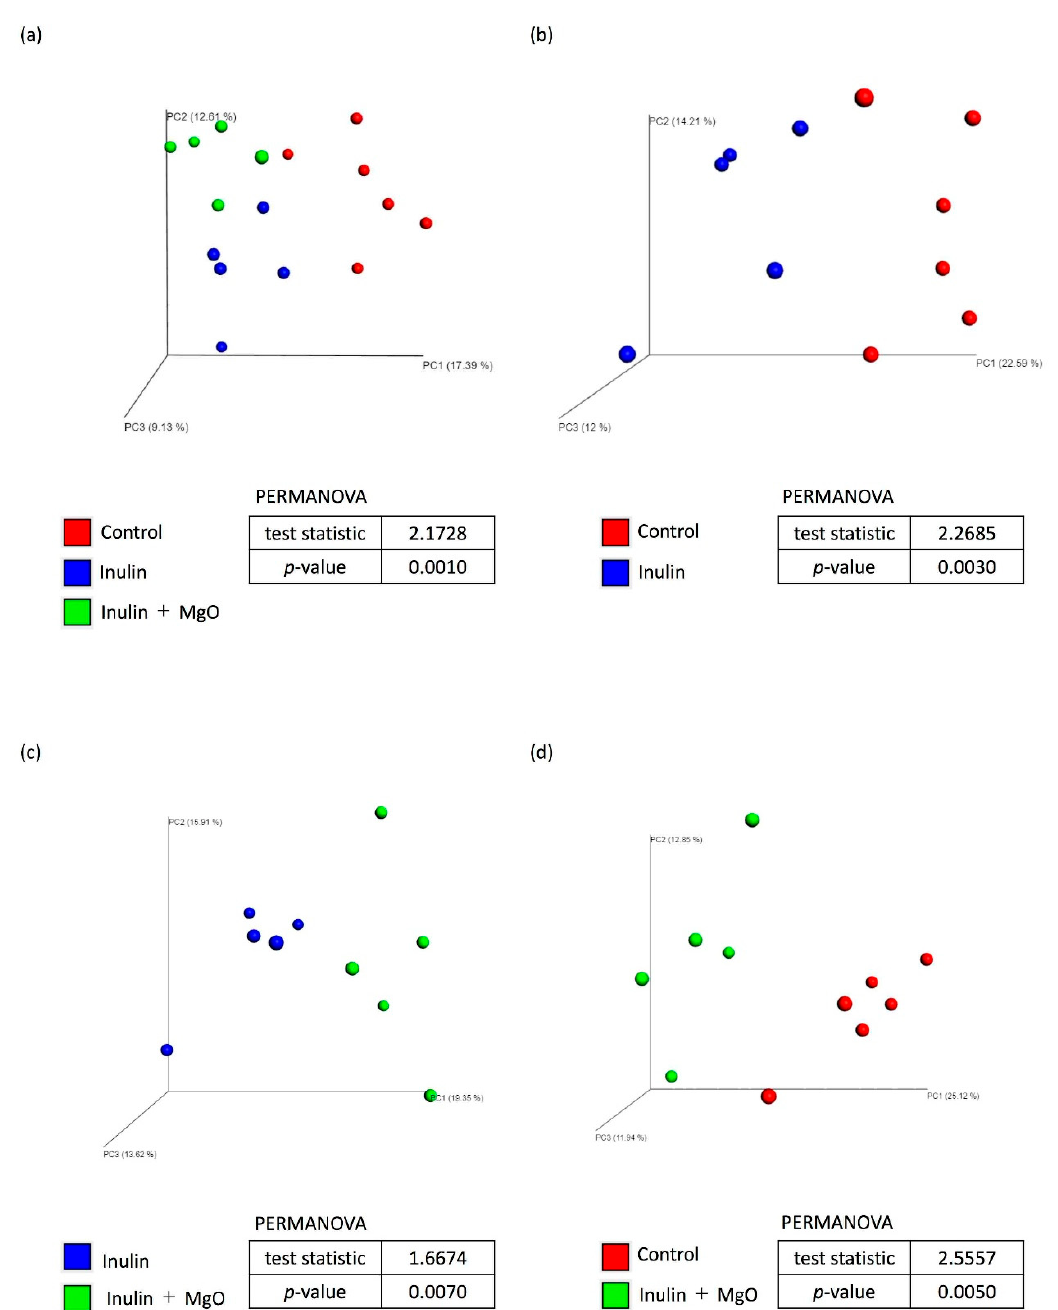
Figure 4. The combined inulin and MgO effects on microbiota β -diversity in mice on a HFD. ( a ) Control group vs. inulin group vs. inulin + MgO group. ( b ) Control group vs. inulin group. ( c ) Inulin group vs. inulin + MgO group. ( d ) Control group vs. inulin + MgO group. Inulin was mixed with the HFD at a ratio of 2.5% in the inulin group and the MgO combination group. Magnesium oxide was given in the diet at a ratio of 0.25%. PCoA plots were calculated using unweighted UniFrac distance. (Each group n = 5–6). All data in tables were analyzed by a permutational multivariate analysis of variance (PERMANOVA). MgO: magnesium oxide. HFD: high-fat diet.